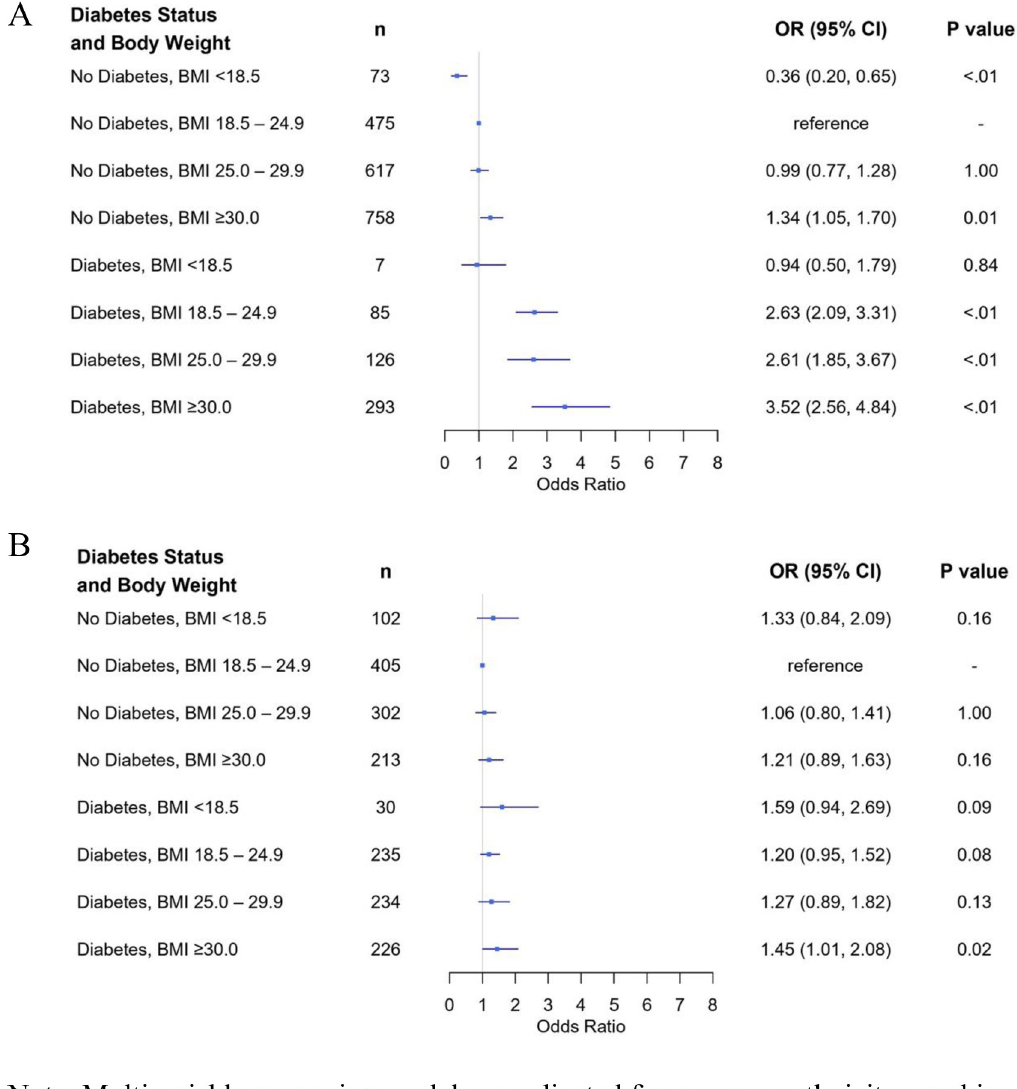
Fig 1. Forest plot of adjusted risk factors for COVID-19 disease severity among patients (A) < 65yo and (B) � 65yo.